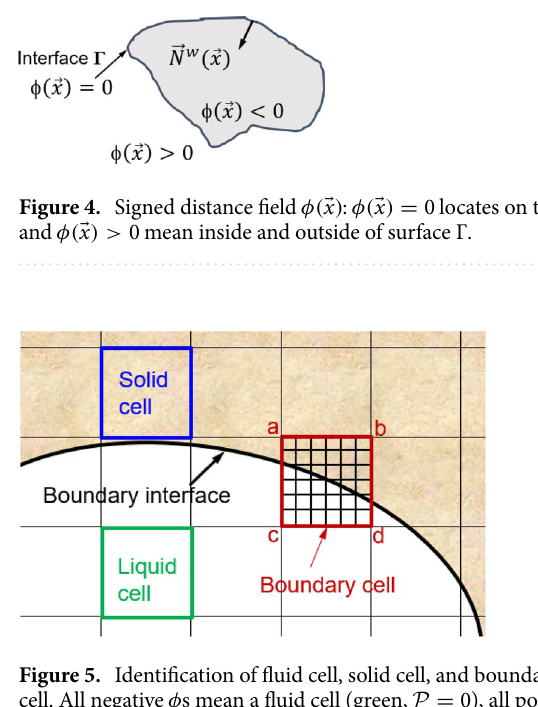
Figure 5. Identification of fluid cell, solid cell, and boundary cell based on the φ signs at four vertexes of